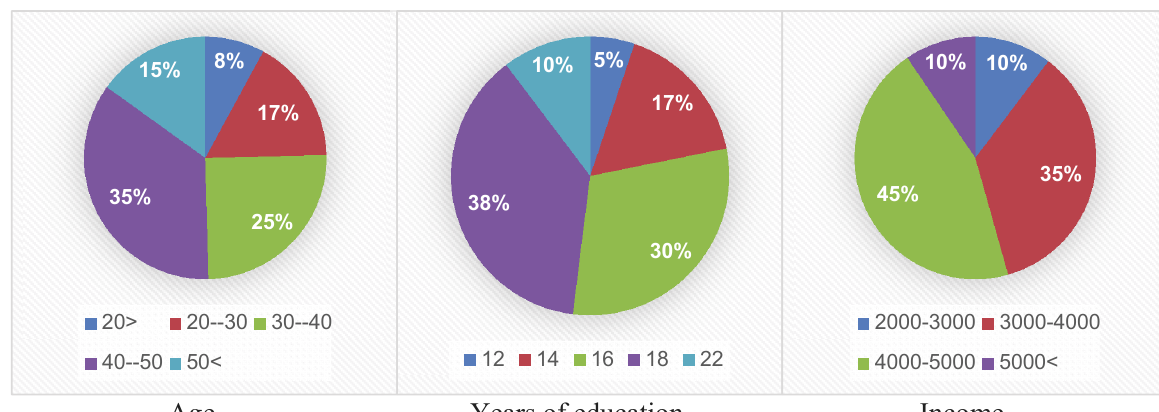
Fig. 1. Personal characteristics of the participants